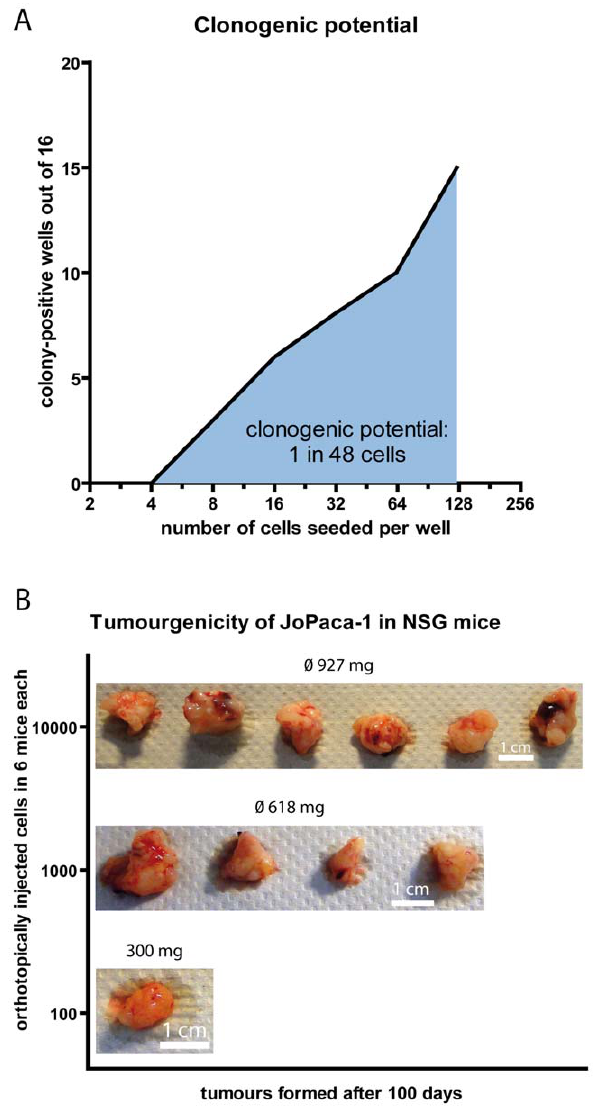
Figure 4. Clonogenic potential and tumourgenicity. Clonogenic potential and tumourgenicity of JoPaca-1 were determined by limiting dilution assays in vitro and in vivo . A. Dilution of cells in a 96-well plate and counting of colony-containing cells after 10 days lead to a clonogenic potential of 1 cell in 48 as calculated by ELDA [32]. B. Orthotopic injection of 10.000, 1.000, and 100 JoPaca-1 cells into 6 NOD.Cg- Prkdc scid Il2rg tm1Wjl mice each resulted in formation of tumours which were excised, weighted and photographed. Average tumour masses are shown.